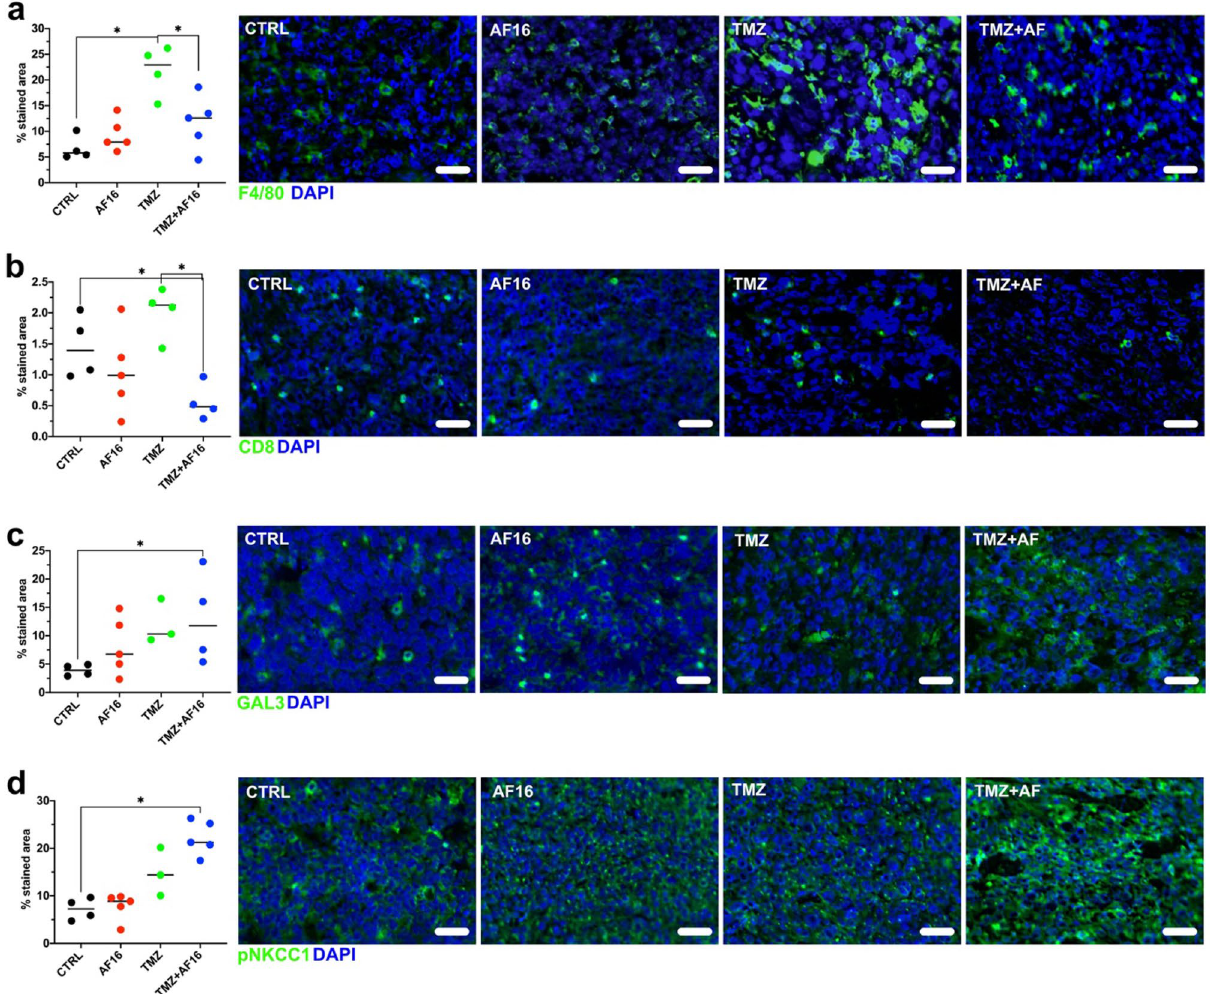
Figure 3. Changes in expression of immune cell surface markers and immune-related molecules caused by AF16 and TMZ treatment compared to untreated animals. Representation of immunohistochemical staining of brain sections of GL261-bearing mice shows an increase of F4/80 + macrophages after TMZ treatment was abolished by addition of AF16 (TMZ compared to TMZ + AF16 p = 0.032 *) ( a ). A decrease in CD8 + T cells was recorded after the combination treatment with TMZ and AF16 compared to untreated animals and TMZ alone (CTRL compared to TMZ + AF16 p = 0.029 *; TMZ compared to TMZ + AF16 p = 0.029 *) ( b ). Increased expression of galectin-3 was seen after the combination treatment with TMZ and AF16 compared to untreated animals (CTRL compared to TMZ + AF16 p = 0.029 *) ( c ). Similarly, the combination of TMZ and AF16 also increased the expression of pNKCC1 compared to untreated animals (CTRL compared to TMZ + AF16 p = 0.002 **) ( d ). Representative pictures are shown for each immunohistochemical staining, values are shown in percent of total tumor area. All tests are nonparametric Mann–Whitney U tests, scale bars correspond to 50